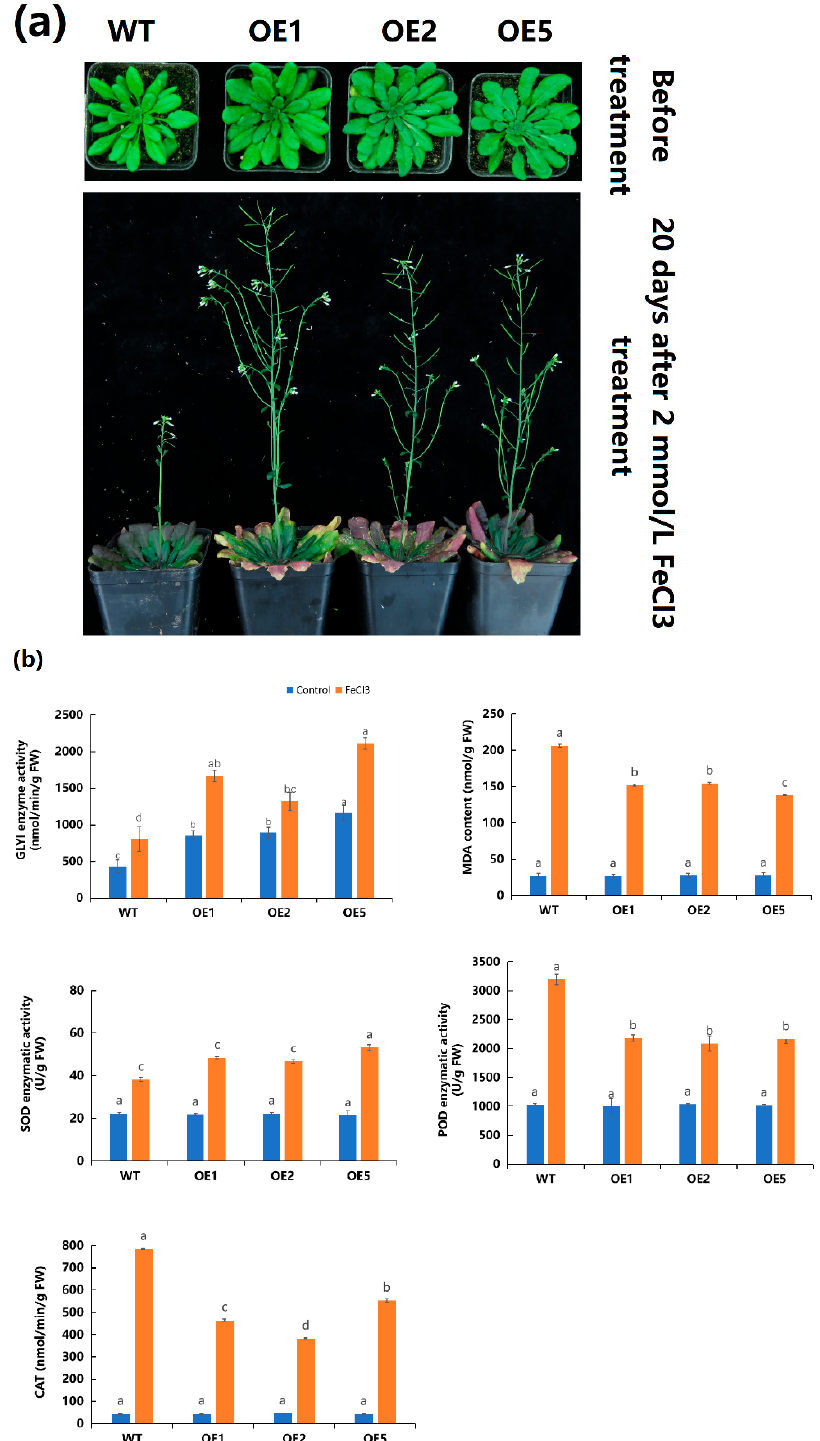
Figure 8. Tolerance of potted MeGLYI-13 transgenic Arabidopsis to iron stress. ( a ) Comparison of phenotypic differences between the transgenic and WT Arabidopsis under 2 mmol/L of FeCl 3 stress for 20 days. ( b ) The changes in GLYI, MDA, SOD, POD, and CAT in the transgenic and WT Arabidopsis under 2 mmol/L of FeCl 3 stress for 20 days. Values are means and standard deviations (n = 3). The different letters (a, b, c and d) on the bars indicate the significant difference between the plant lines at p ≤ 0.05. WT, wild type.